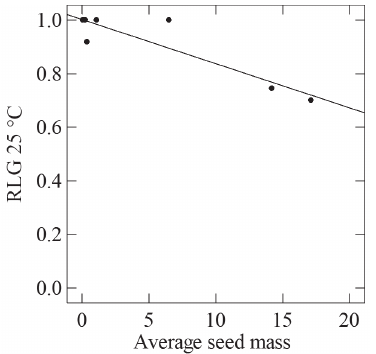
Figure 1 - Relationship between average fresh seed mass and Relative Light Germination (RLG) at 25 °C of seven pioneer tree species from the Central Amazon. RLG: Germination percentage recorded in the light divided by the sum of germination percentages observed in the light and in